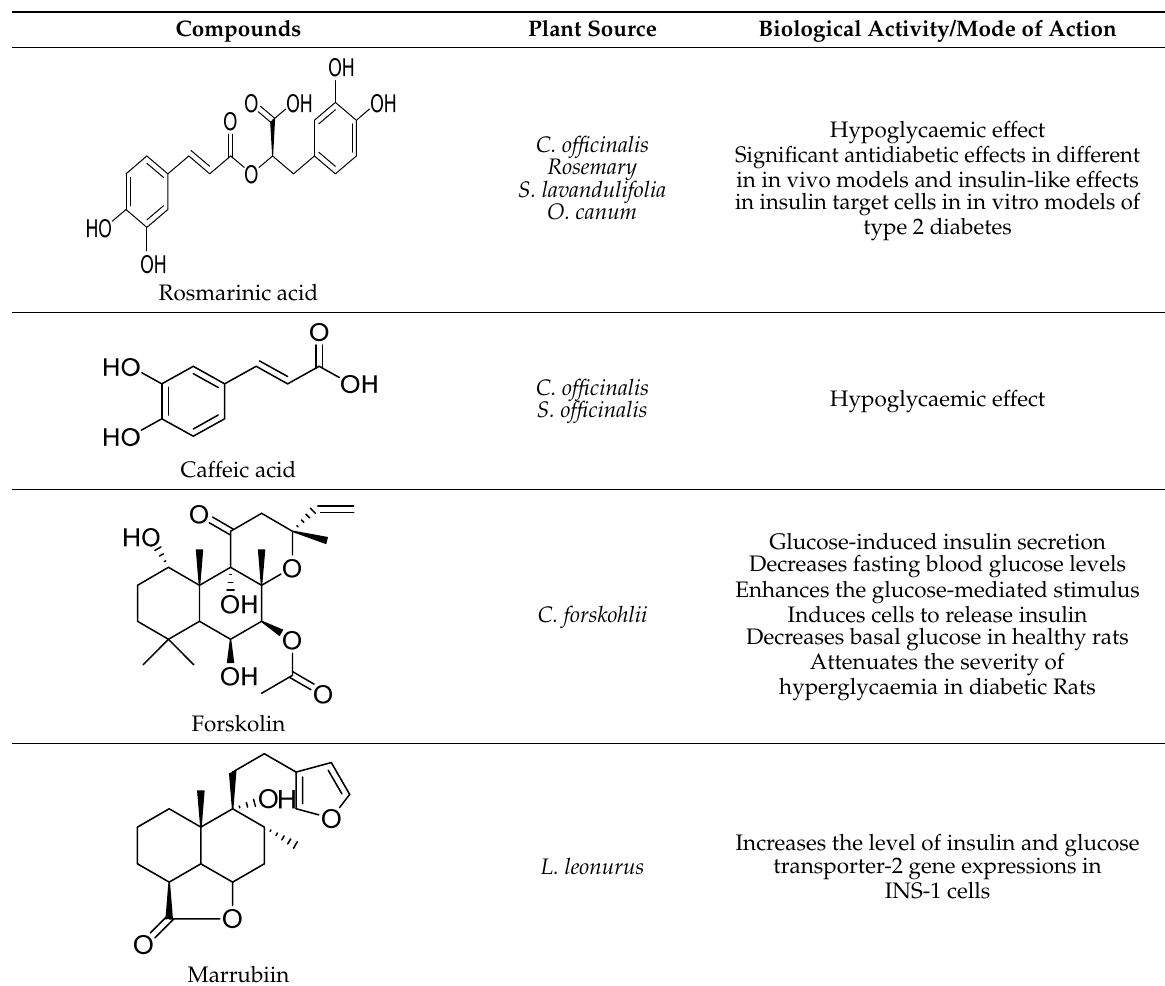
Table 2. The hypoglycaemic effects of numerous compounds such as luteolin, apigenin,